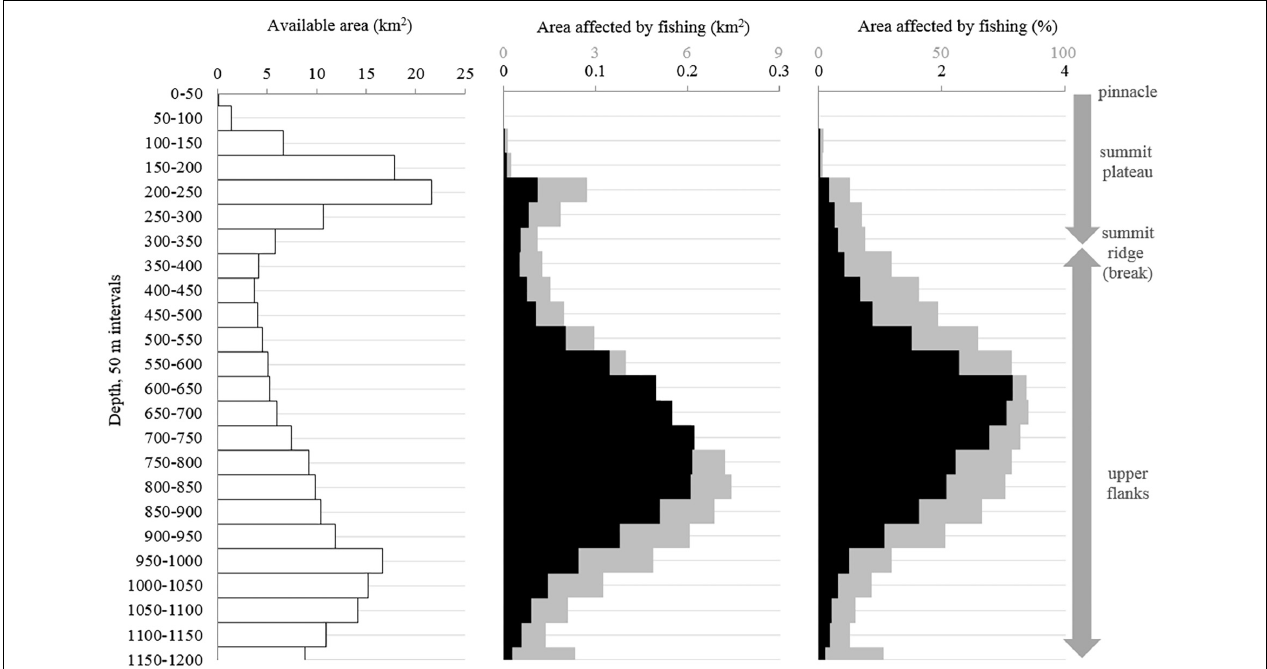
FIGURE 9 | The distribution of (A) the available area of each 50 m depth-interval, (B) the area affected by the 1996–2017 bottom longline fishing using two scenarios, and (C) the percentage of the available area affected by the fishing. Scenario 1 assumes there is little to no movement of traps on the seafloor (black). Scenario 2 assumes there is moderate movement (100 m lateral sweep;